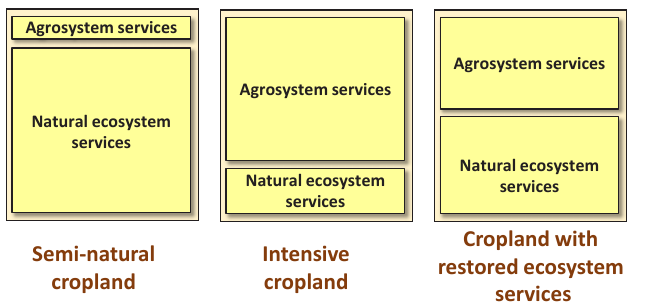
Figure 1: Share of agrosystem services and natural ecosystem services in differently managed cropping- systems. The outputs of all three systems are different amounts of agroecosystem